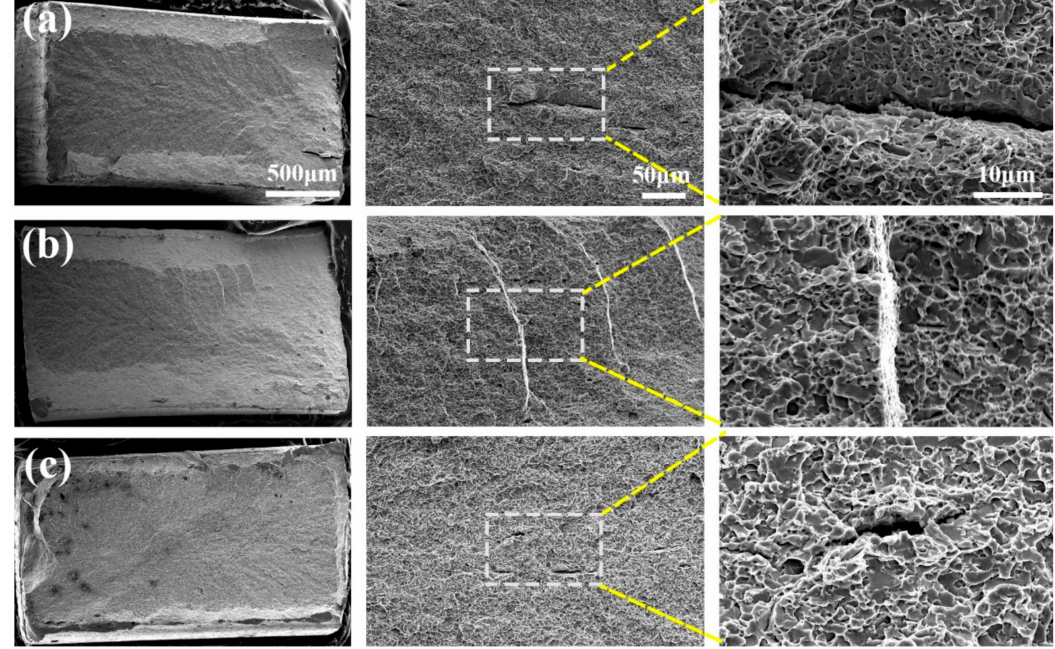
Figure 8. SEM micrographs of the fracture surface of ( a ) UFG-DP1; ( b ) UFG-DP2; and ( c )